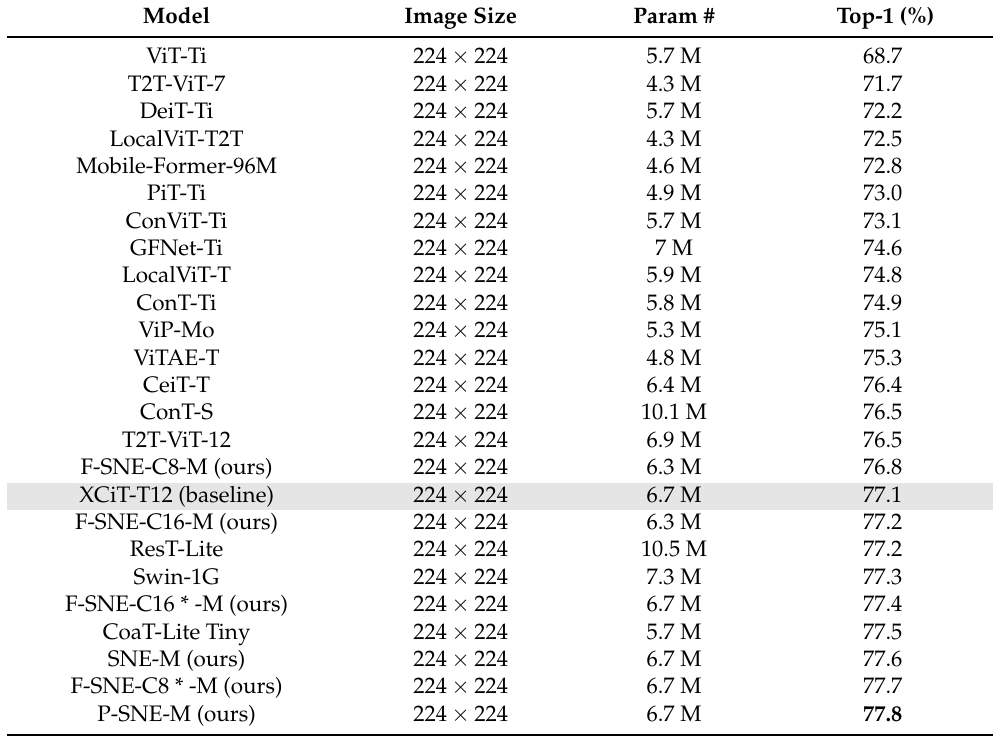
Table 3. Proposed models were evaluated on ImageNet classification task. The number of parameters was constrained to be below 10 M to be compared to the medium (M)